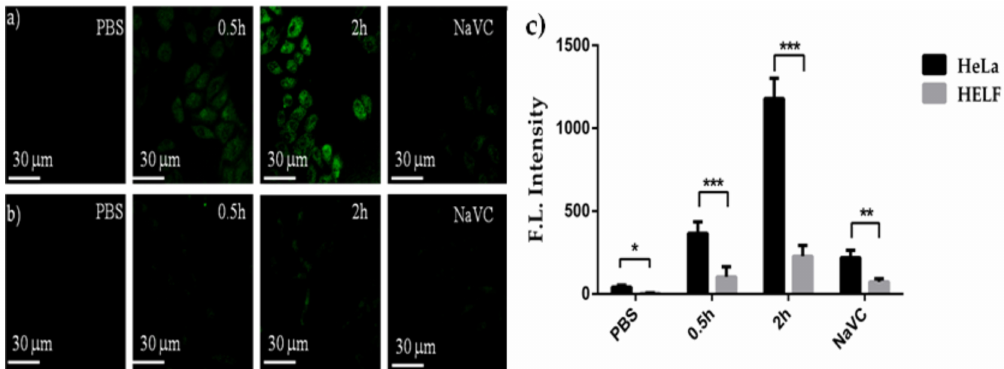
Figure 10. CLSM images of ( a ) HeLa cells and ( b ) HELF cells incubated with compound 7 (5 µ M) for 0.5 h and 2 h respectively, or cells by co-culturing with compound 7 (5 µ M) and NaVC (100 µ M) for 2 h and the PBS group used as a control to evaluate the basal ROS levels in the absence of compound 7 . The green fluorescence is DCF signals; ( c ) quantitative results of ( a ) and ( b ) (* p < 0.05, ** p < 0.01, *** p < 0.001).